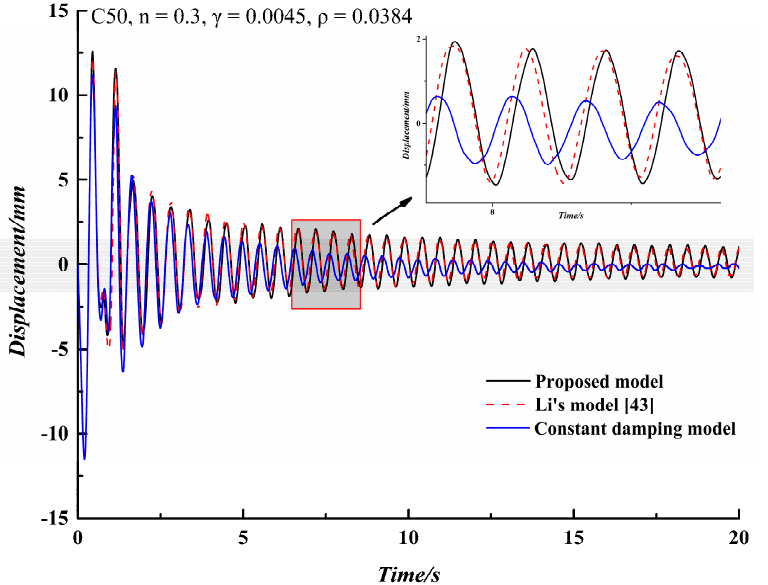
Figure 7. The column head displacement response of FRP-C RC columns with circular section under uniaxial harmonic load (C50, n = 0.3, γ = 0.0045, ρ = 0.0384).